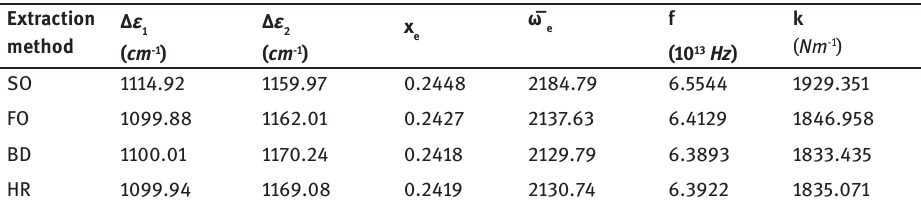
Table 4: Anharmonic constant value ( Nm -1 ) with asymmetry stretching vibration of C-O from